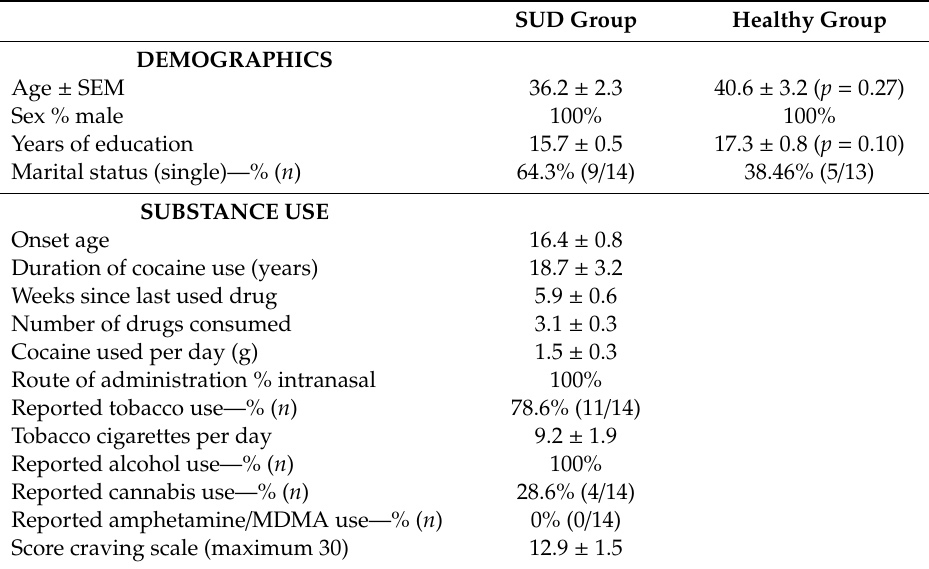
Table 1. Demographic, substance use characteristics of